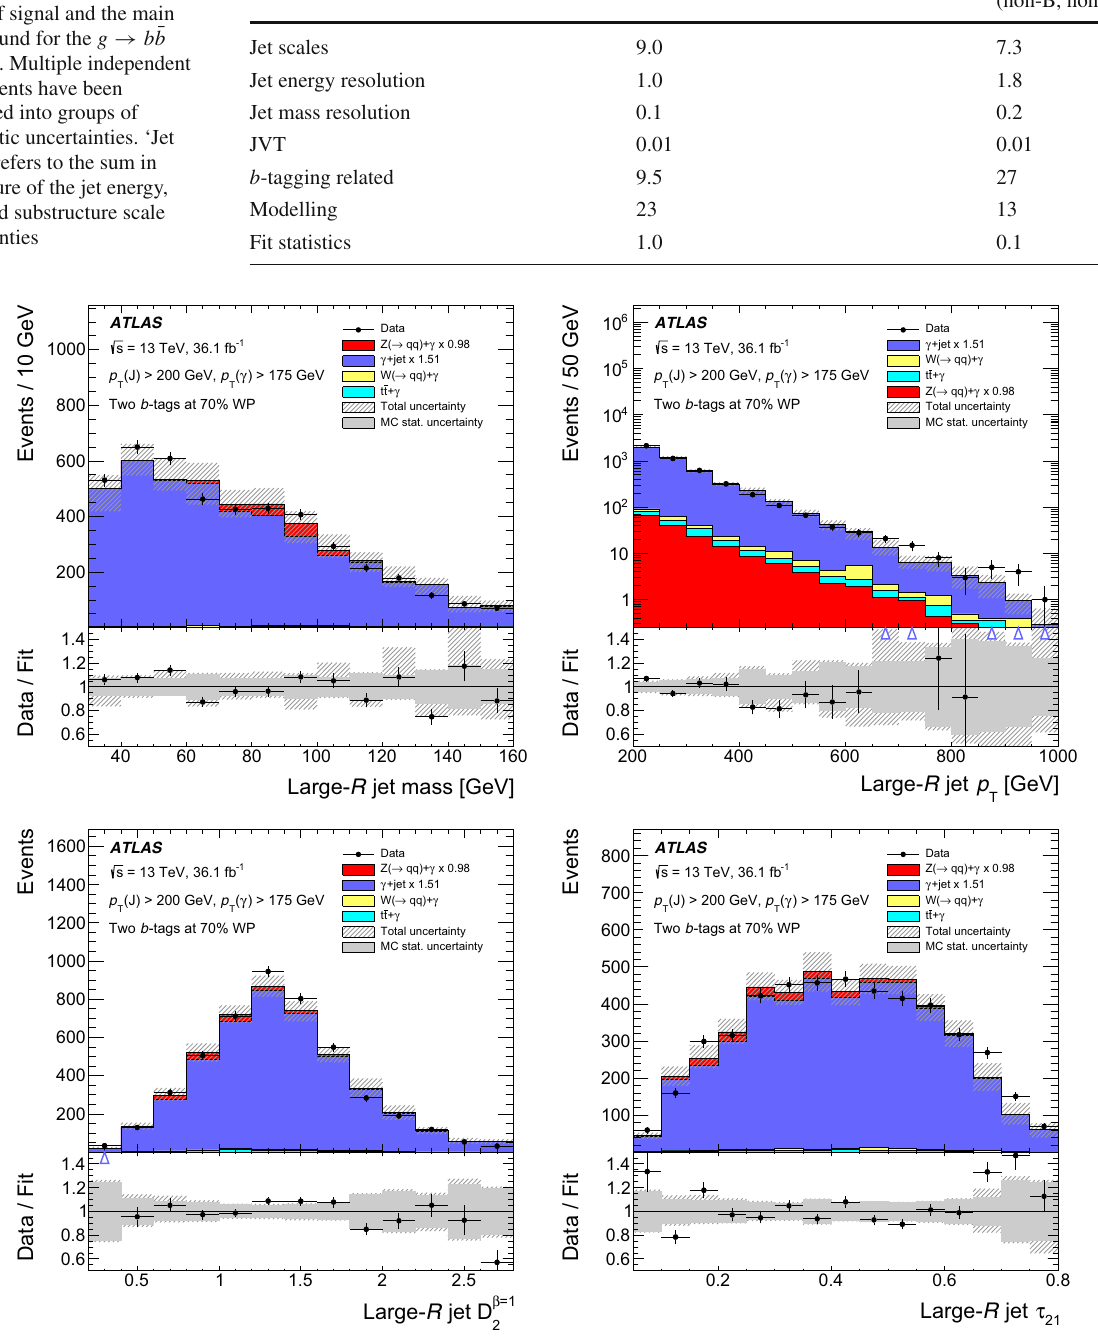
β = 1 Fig. 18 Jet mass, p T , D and τ 21 distributions. Events with two b - 2 tagged track-jets are used. The γ + jets background and the Z → b ¯ b